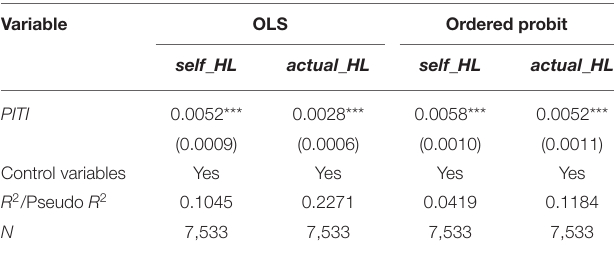
TABLE 9 | Regression results of OLS and ordered probit models. TABLE 10 | Regression results of IV-Ordered